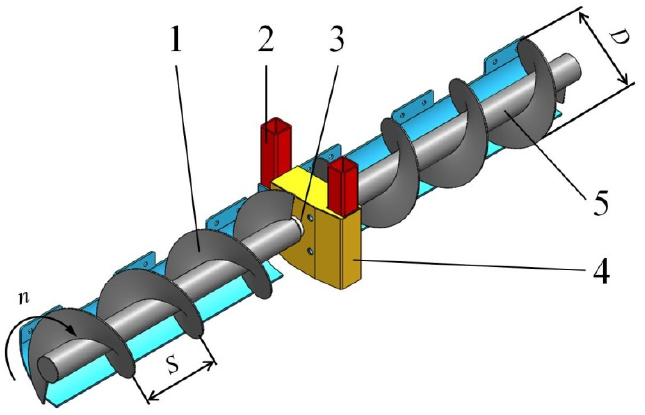
Figure 2. Critical parameters of SDM. 1, Spiral blade; 2, support-connecting frame; 3, rolling bear- ing; 4, inclined anti-winding plate; 6, spiral shaft; 5, holding hopper. D is the outer diameter of the spiral blade, m; S is pitch, m; n is the RVSS,